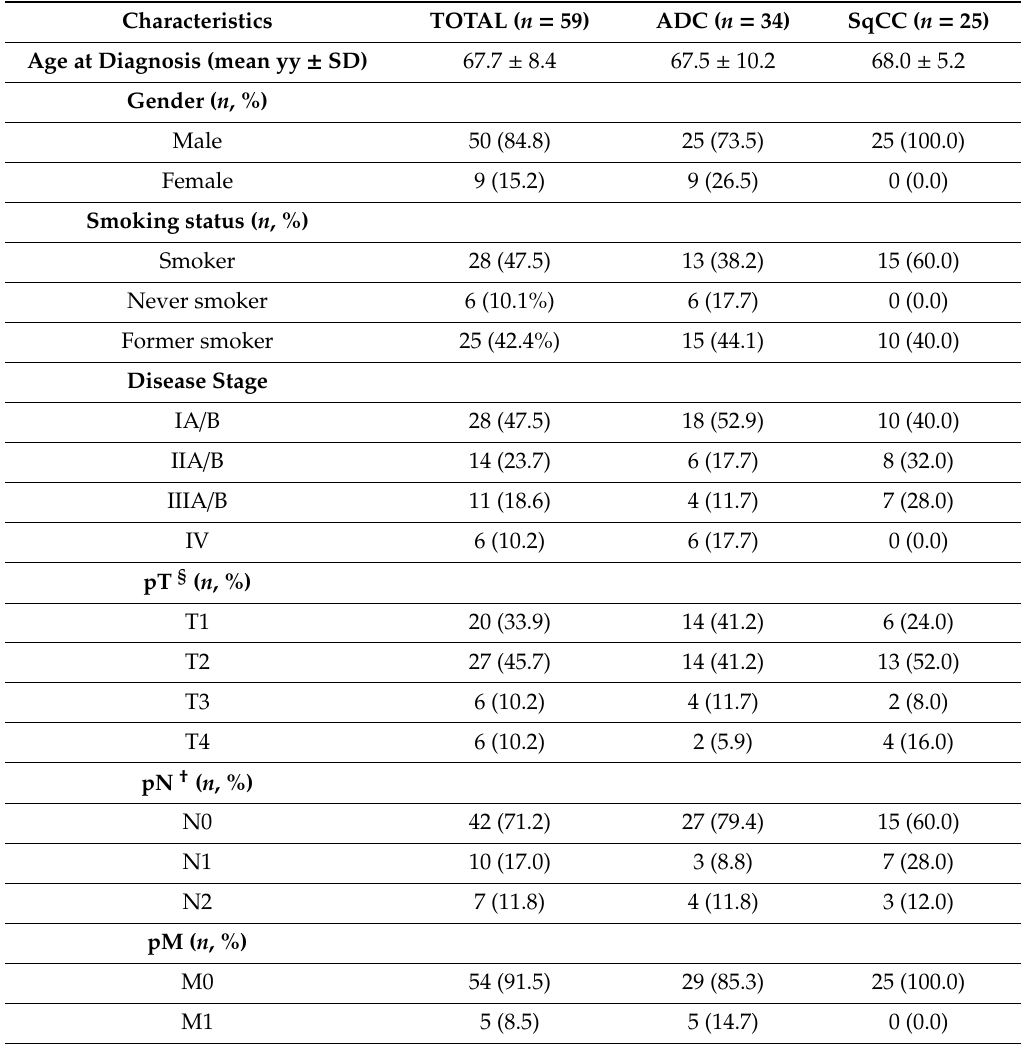
Table 1. Clinical, tumor stages and histological features of NSCLC a ff ected patients enrolled for the study ( n =